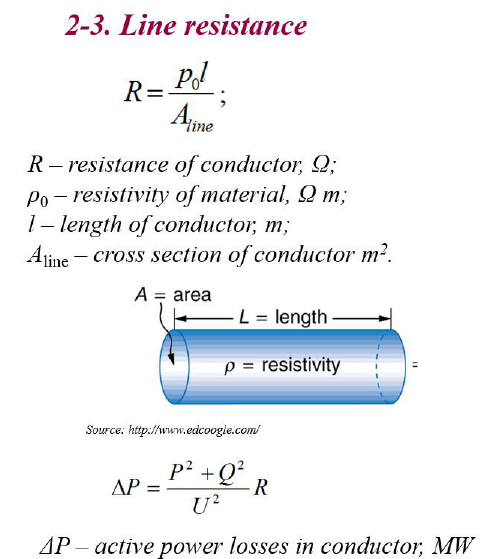
Fig. 3. A part of a slide with explanation of resistance and active power